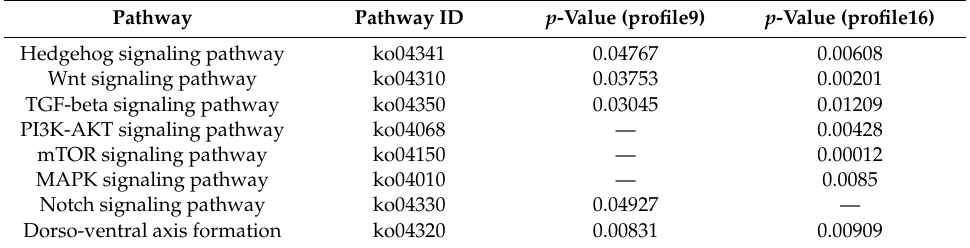
Key pathways significantly enriched from profile 9 and profile 16 in U. unicinctus larval